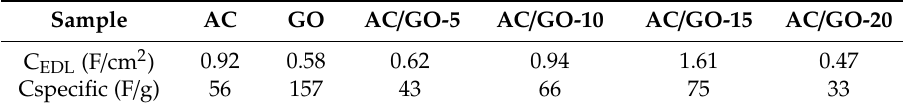
Figure 8. Cyclic voltammetry curve of ( a ) AC, GO and AC/GO-x composite electrodes at the scan rates of 2 mV/s; ( b ) AC/GO-x electrodes at scan rate of 2 mV/s; ( c ) AC, GO and AC/GO-x composite electrodes at the scan rate of 200 mV/s; ( d ) Double-layer capacitance measurements for AC, GO and AC/GO-x composite electrodes voltammetry with 0.5 M NaCl. Cyclic voltammograms were measured in a non-Faradaic region of the voltammogram at low scan rates of 2–10 mV/s. The cathodic (ref current density below 0 mA/cm 2 ) and anodic charging currents (ref current density above 0 mA/cm 2 ) plotted as a function of scan rate (mV/s). The determined double-layer capacitance of the system was taken as the average of the absolute value of the slope of the linear fits to the data [20]. Table 3. Electrical double layer capacitance (C EDL ) and specific capacitance (C Specific ) for AC and AC/GO-x electrodes.